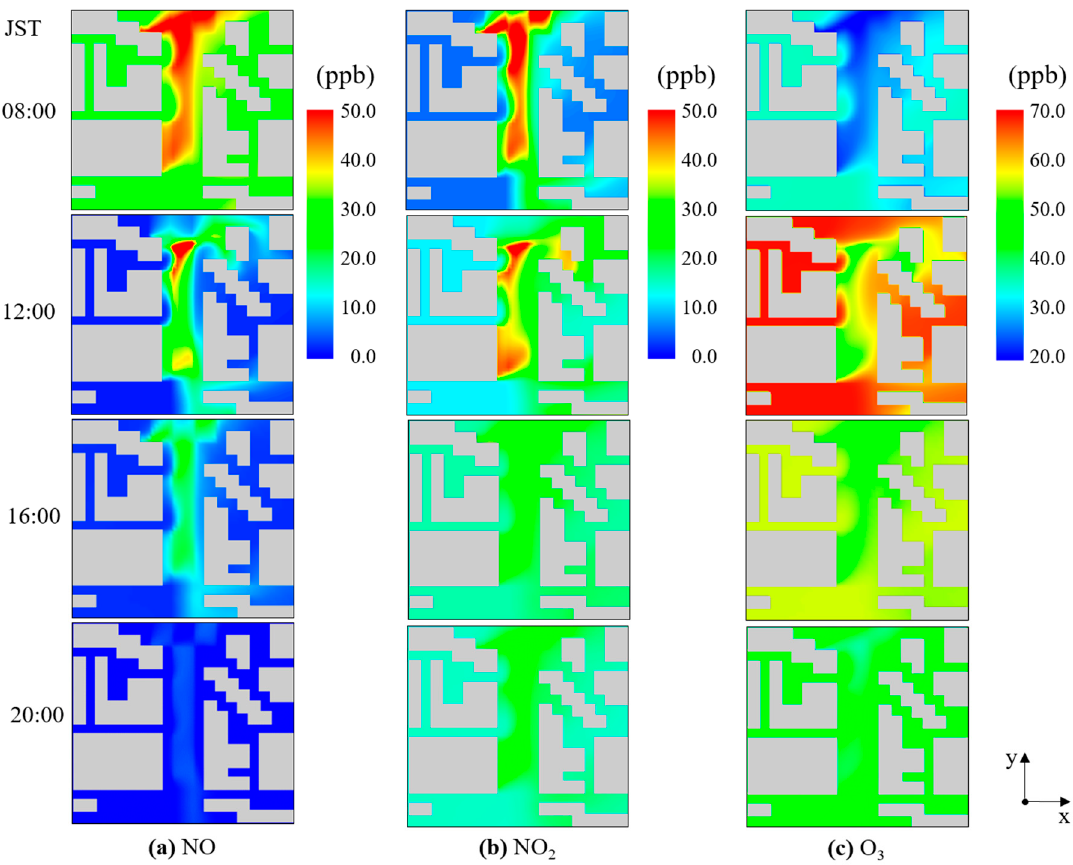
Figure 8. Spatial distribution of ( a ) NO, ( b ) NO 2 , and ( c ) O 3 concentration at 08:00, 12:00, 16:00, and 20:00 JST, cross-section B-B’ view (Figure 2b).